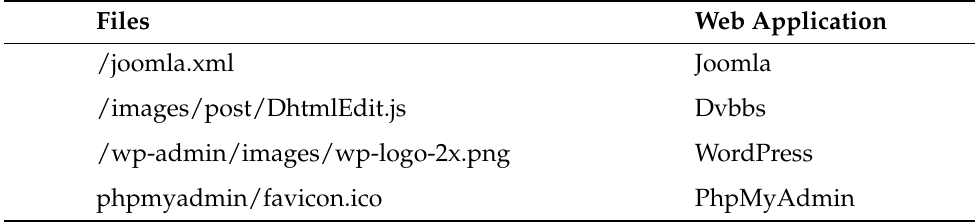
Table 6. Static file characteristics of Web